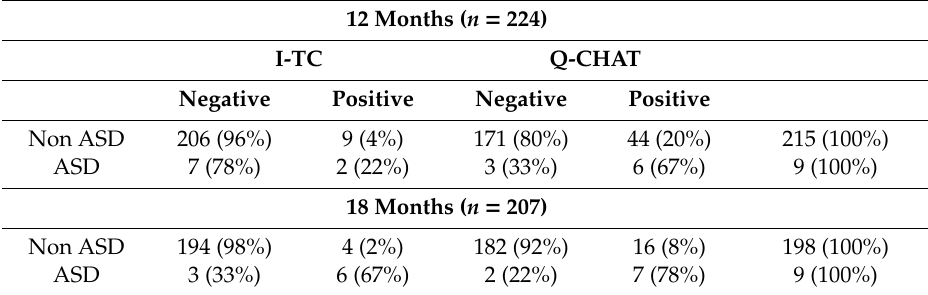
Table 2. Contingency tables of positivity to ASD and BAP at 36 months and positivity to I-TC and Q-CHAT at 12 and 18 months.